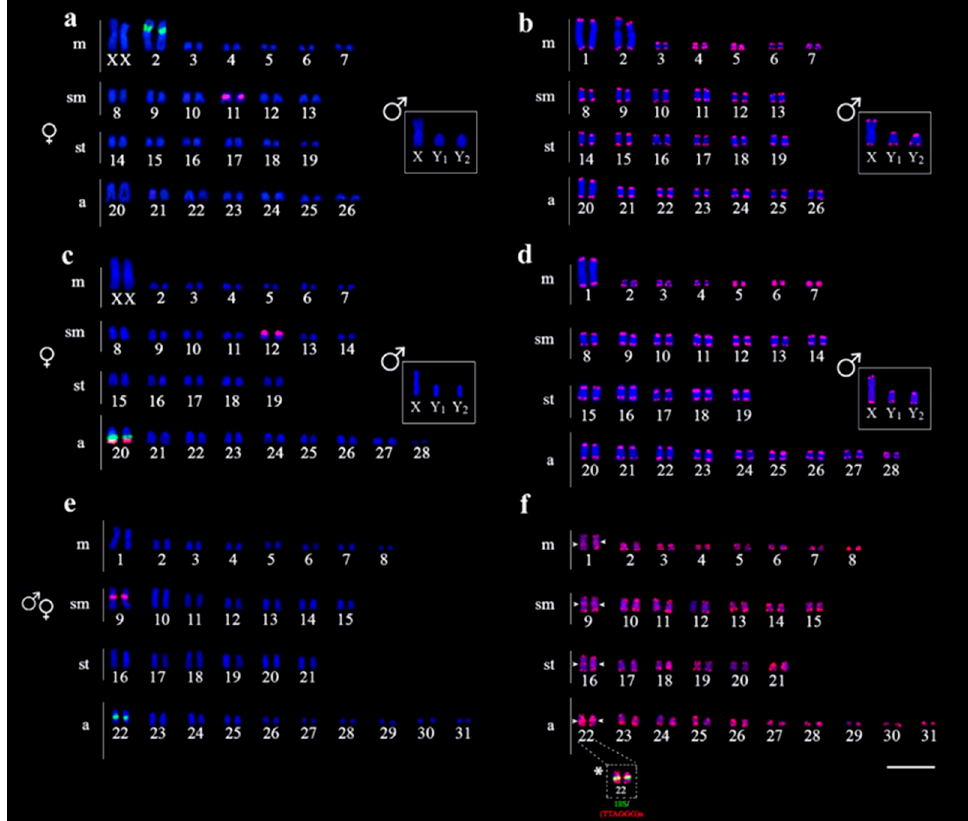
Figure 3. Karyotypes of H. intermontana ( a , b ), Harttia sp. 1 ( c , d ), and Harttia sp. 2 ( e , f ) arranged after FISH with 5S rDNA (red) and 18S rDNA (green) probes ( a , c , e ), and telomeric (TTAGGG)n probe ( b , d , f ). Inserts depict the male sex chromosomes. Arrowheads indicate the interstitial telomeric sites (ITS) locations and the (*) signals the joint localization of the 18S and ITS sites. Bar = 5 μ m.